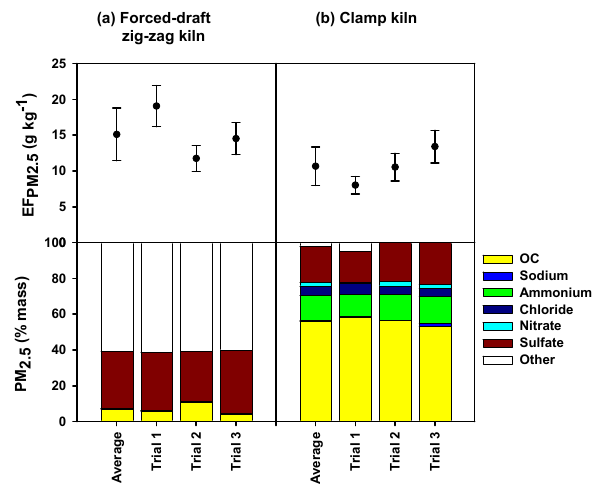
Figure 1. EF PM and PM 2 . 5 composition (as percent by mass) for 2 . 5 forced-draft zigzag kilns (a) and clamp kilns (b) . For the average EF PM , error bars for averages correspond to 1 standard deviation, 2 . 5 while those for individual trials show the analytical uncertainty. EC was not detected in brick kiln emissions; optical measurements of BC from Stockwell et al. (2016) are provided in Table